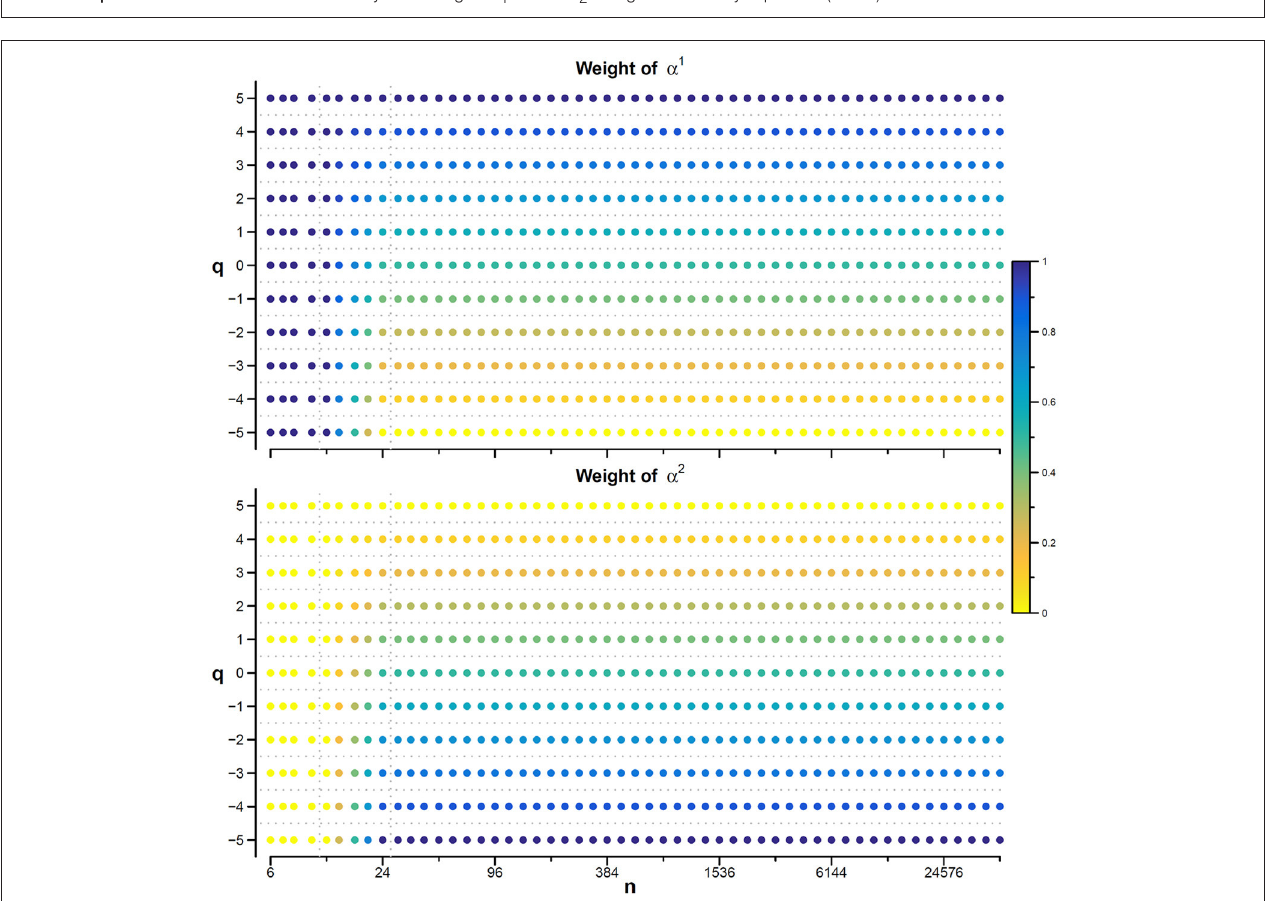
FIGURE 7 | Weights for combining DFA 1 and DFA 2 estimates. The weighted estimate, α w ( q,n ), is a linear combination of DFA 1 coefficients, α 1 ( q,n ), and DFA 2 coefficients, α 2 ( q,n ), and it is proposed if there are no specific reasons to prefer one of the two detrending orders and if the time-series dynamics is assumed to be composed by fractional Gaussian noises or fractional Brownian motions. The weights, based on Equations (23), range between 0 (yellow) and 1 (dark blue). When n ≤ 12, α w = α 1 for all q values; when n ≥ 24, α w = α 1 for q = 5, α w = α 2 for q = − 5, and α 1 and α 2 weights change linearly with q between − 5 and + 5 so that α w is the average between α 1 and α 2 for q = 0. The α 1 and α 2 weights change linearly also with n between 12 and 24.